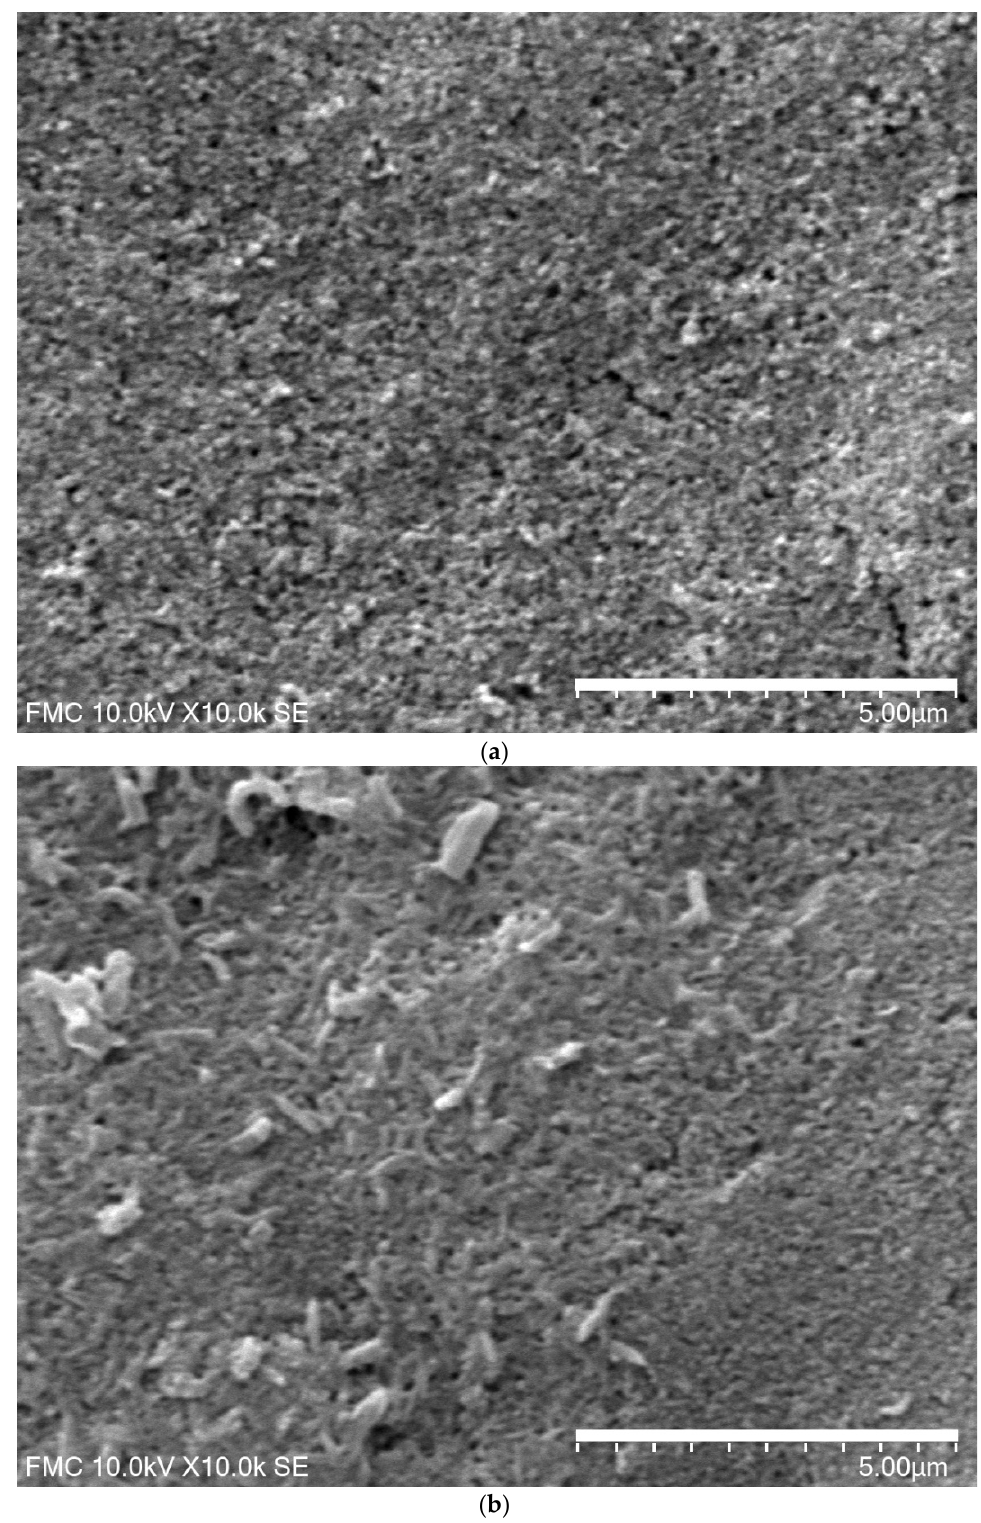
Figure 1. The SEM image of sensors surface ( a ) MC-SPCE and ( b ) OMC-SPCE.